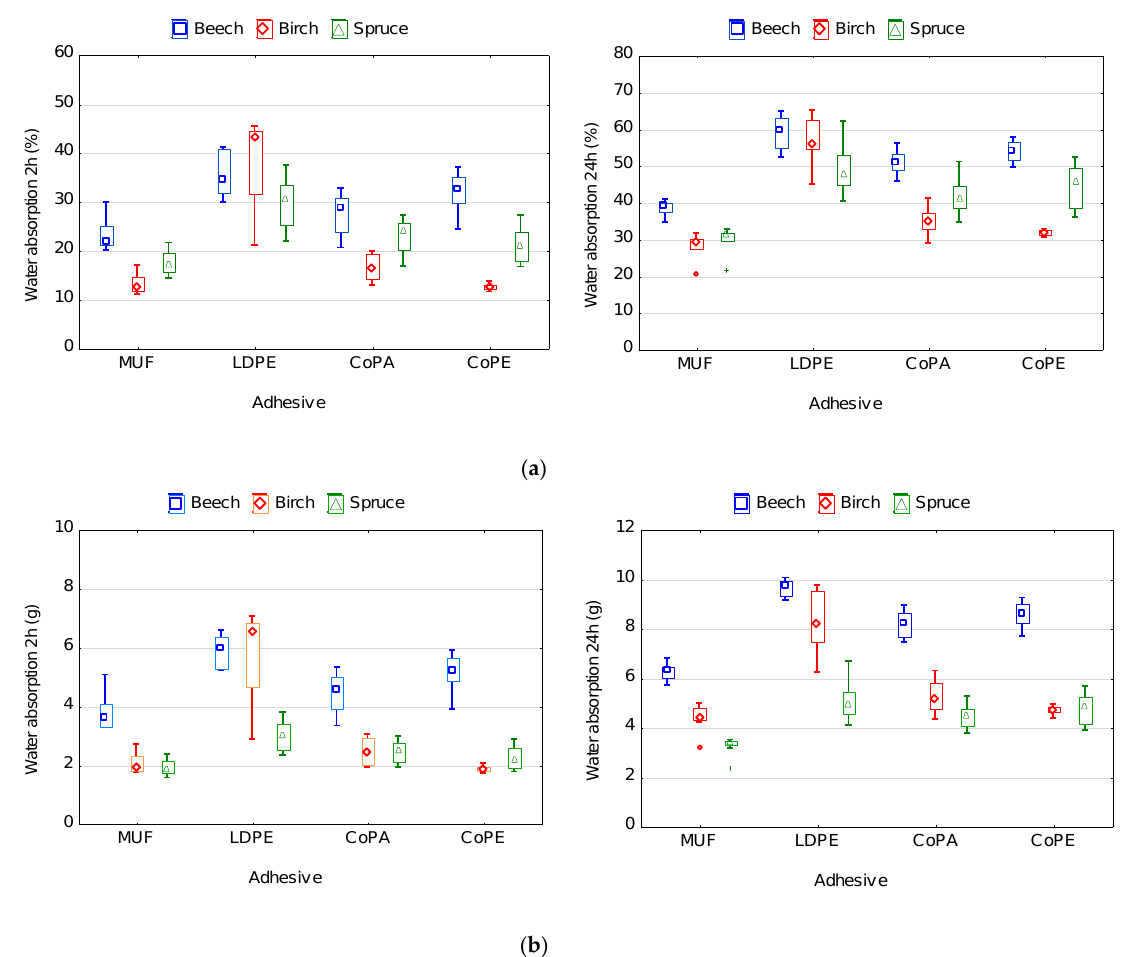
Figure 5. Thickness swelling of plywood panels bonded with different types of adhesive and using various wood species.